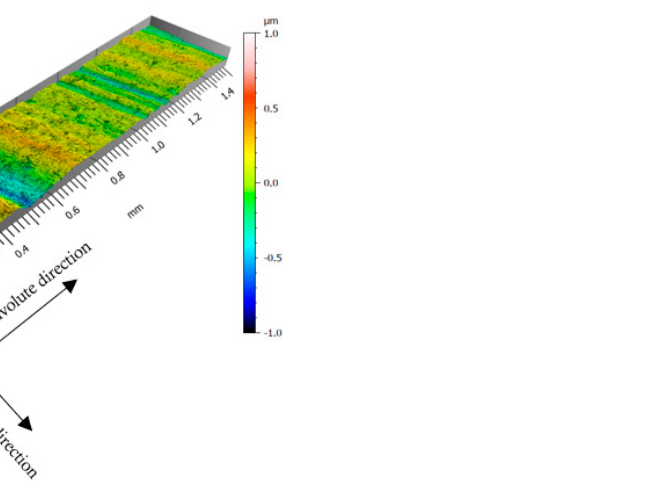
Figure 11. Visibility of the tooth flank before the abrasive process optimization (Stream Finishing).